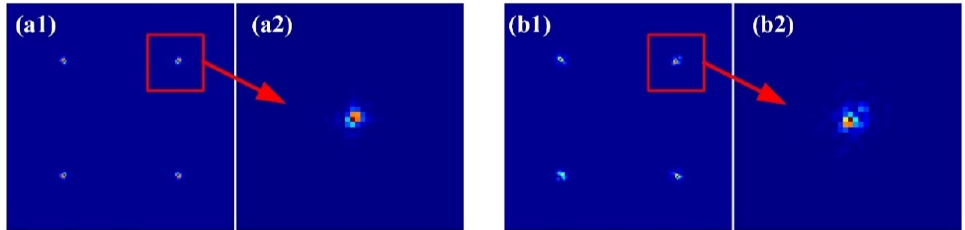
Figure 5. The spot array image and single sub-spot. ( a1 , a2 ) The spot array image and sub-spot from SHWFS. ( b1 , b2 ) The spot array image and sub-spot from FBPM-SHWFS.